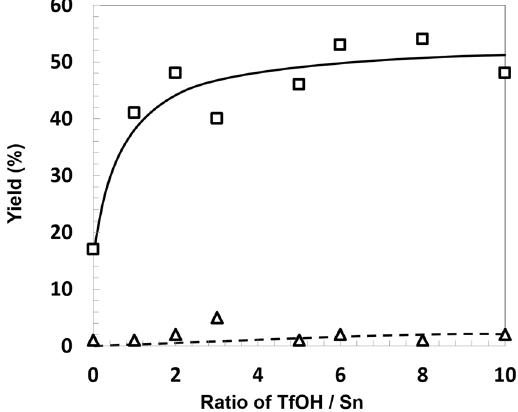
Figure 2. Influence of the ratio of Sn to OTf ions on the yields of 1 and 2 . Reaction conditions: starch (50 mg), methanol (5.0 mL),